Question: Write the caption for this figure.
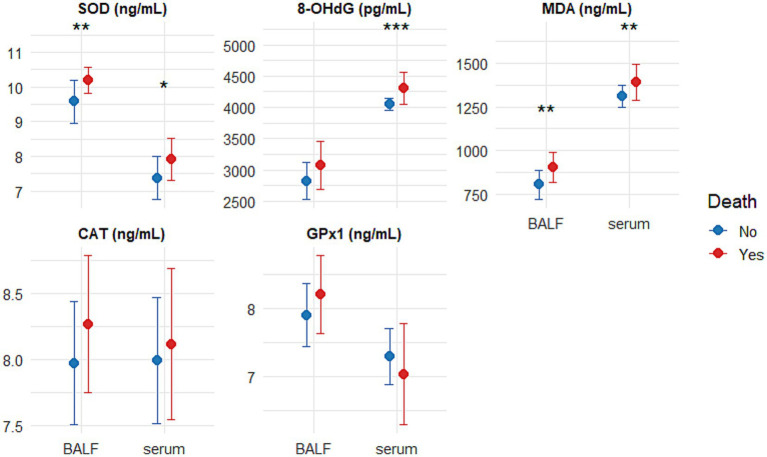
Answer: Serum and BALF (bronchoalveolar lavage fluid) concentrations of selected oxidative stress markers in surviving and non-surviving patients. Non-survivors exhibited significantly higher mean superoxide dismutases (SOD) levels in both BALF ( p = 0.007) and serum ( p = 0.032), higher malondialdehyde MDA levels in both compartments (BALF: p = 0.004; serum: p = 0.009), and higher serum hydroxydeoxyguanosine (8-OHdG,) concentrations ( p < 0.001). No significant differences were observed for catalase (CAT) or glutathione peroxidase (GPx) in either compartment. The difference in BALF 8-OHdG between groups did not reach statistical significance ( p = 0.056).